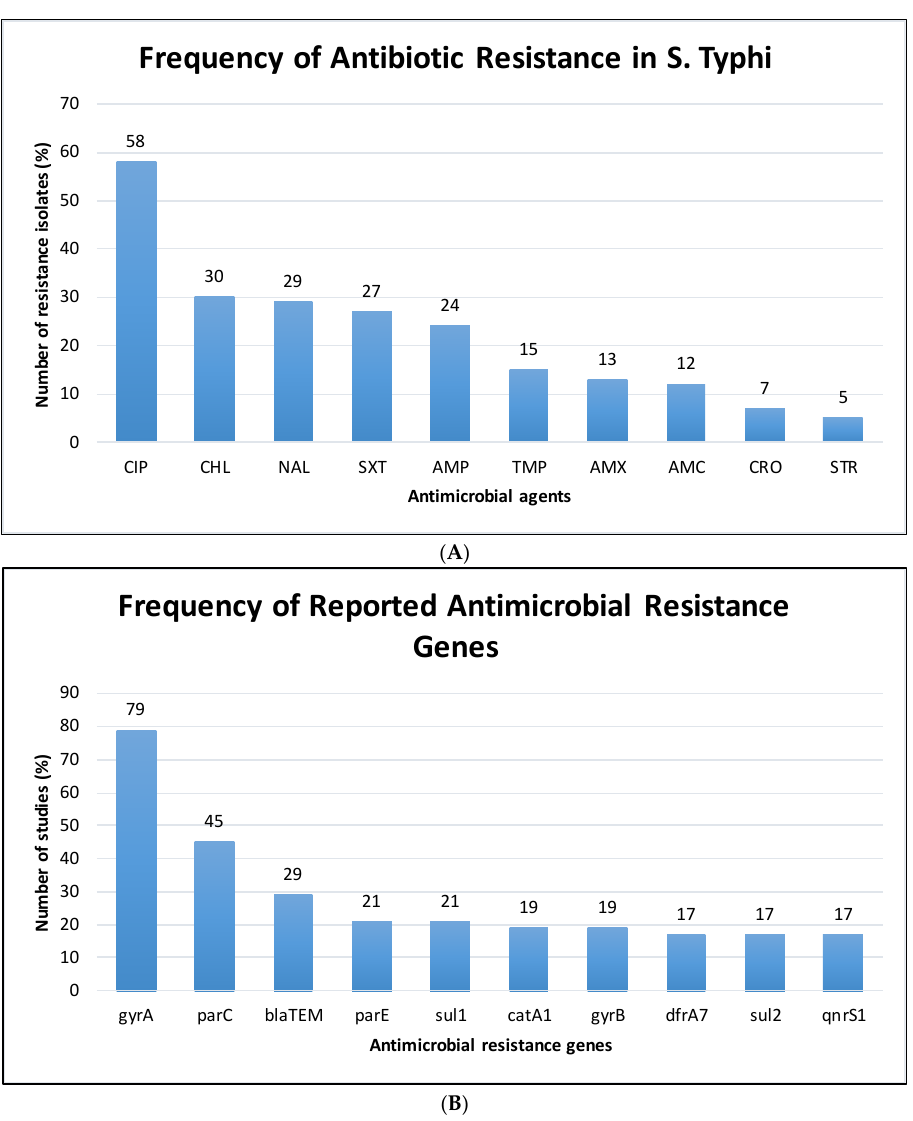
Figure 2. The frequency of top ten ( A ) antibiotic resistance in S. Typhi and ( B ) reported antimicrobial resistance genes. AMC: amoxicillin-clavulanic acid, AMP: ampicillin, AMX: amoxicillin, CHL: chloramphenicol, CIP: Ciprofloxacin, NAL: nalidixic acid, CRO: ceftriaxone, STR: streptomycin, SXT: trimethoprim-sulfamethoxazole and TMP: trimethoprim. 3.3. The Pooled Prevalence of Antimicrobial Resistant Strains in S. Typhi The pooled prevalence of AMR strains in S. Typhi using a random-effect model was estimated at 84.8% (95% CI; 77.3 – 90.2), but with high heterogeneity ( I 2 = 95.35%, p -value < 0.001) (Figure 3). A sub-group analysis based on countries and regions was performed to examine the potential sources of heterogeneity, which were presented in Table 2. The highest pooled prevalence of 98.9% (95% CI; 95.7 – 99.7) was observed from Iraq (n = 4) and the lowest pooled prevalence was estimated at 18.2% (95% CI, 8.4 – 35.0) from Peru (n = 1) Heterogeneity was highest among studies conducted in India ( I 2 = 96.529%) followed by